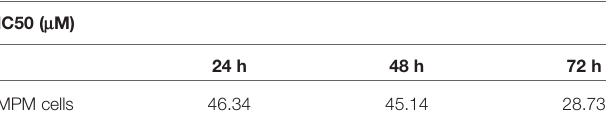
TABLE 1 | IC50 values of apatinib in MPM cells for treatment time of 24 h, 48 h, and 72